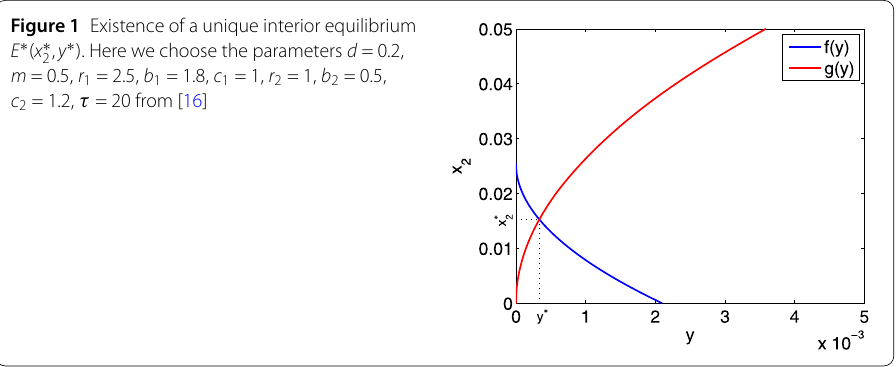
Figure 1 Existence of a unique interior equilibrium E ∗ ( x ∗ 2 , y ∗ ). Here we choose the parameters d =